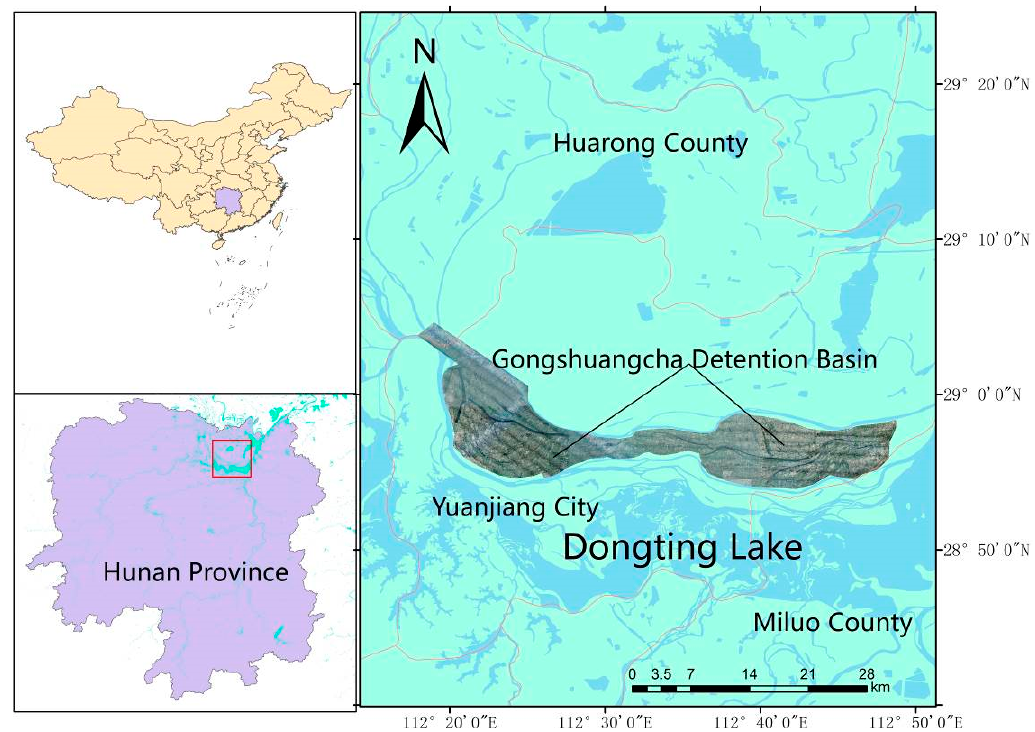
Figure 1. The location of the Gongshuangcha detention basin in the Dongting Lake area.